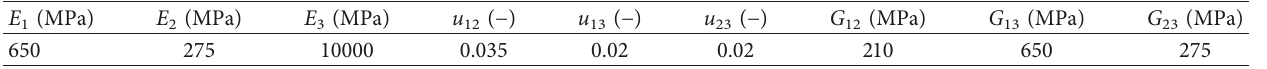
Table 3: Northeast red pine wood constants.